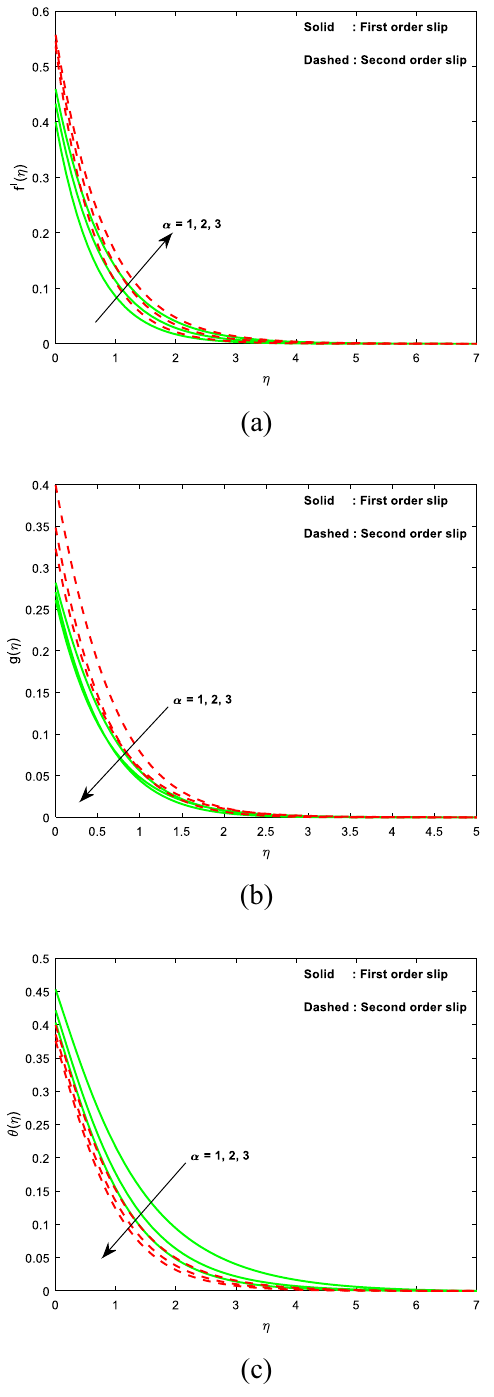
Figure 3. Impact of α on ( a ) velocity ( b ) microrotation ( c )